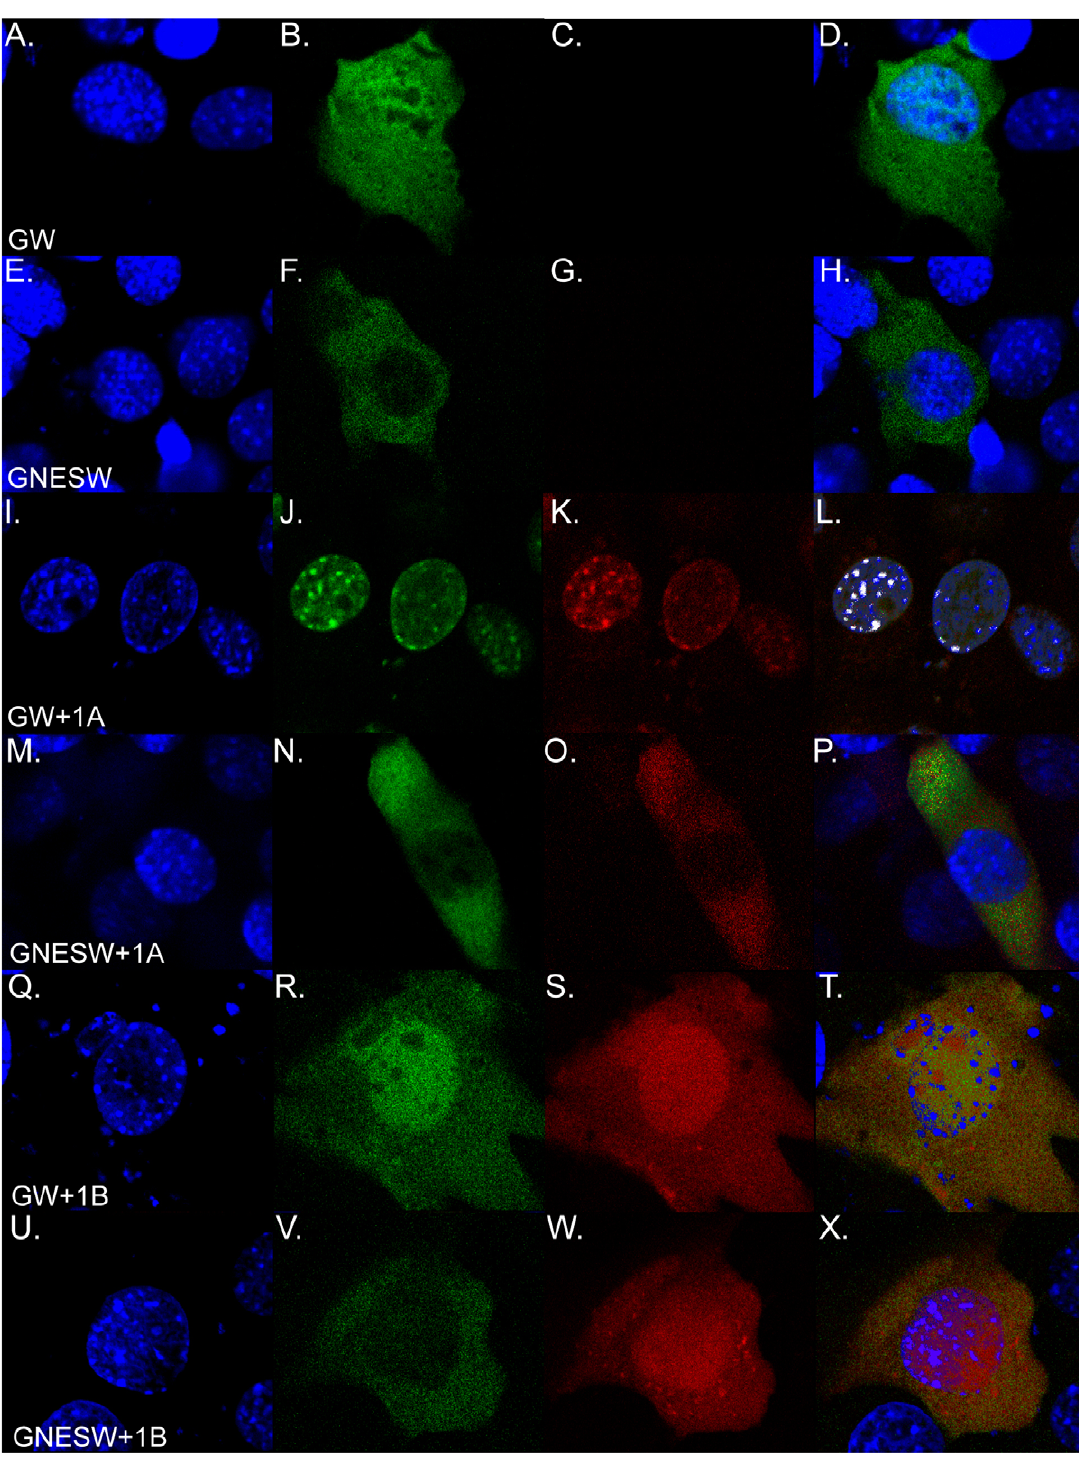
Figure 2. The GFPNESWdr68 fusion redistributes interaction partner Dyrk1a from the nucleus to the cytoplasm in C2C12 cells. A, E, I, M, Q, U) DAPI stained cell nuclei. B, F, J, N, R, V) GFP fusion proteins. C, G, K, O, S, W) mRFP1 fusion proteins. D, H, L, P, T, X) Overlays of blue, green and red channels. A–D) pan-cellular distribution of GFPWdr68 (GW) alone. E–H) Cytoplasmic restriction of GFPNESWdr68 (GNESW) alone. I–L) Redistribution of GW to the cell nucleus when co-expressed with mRFP1-Dyrk1a. M–P) Redistribution of mRFP1-Dyrk1a when co-expressed with GNESW. Q–T) Pan-cellular distribution of GW when co-expressed with pan-cellular mRFP1-Dyrk1b. U–X) Cytoplasmic restriction of GNESW when co- expressed with pan-cellular mRFP1-Dyrk1b.